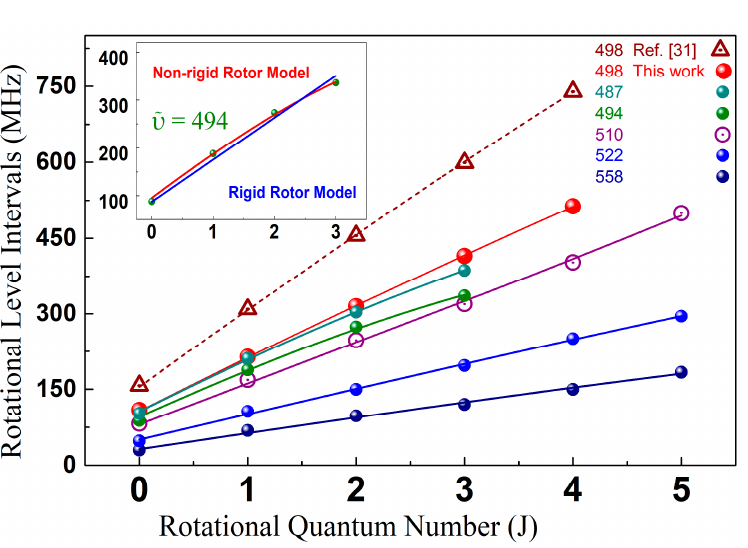
Figure 4. Relationship between J and the frequency rotational intervals ∆ ν for specific ro-vibrational levels in the Cs 2 0 + u state. Experimental data, shown in colorful symbols were fitted by the nonlinear non-rigid-rotator model. The former incorrect calibrated values for ˜ v = 498 [31], which were misprinted as ˜ v = 499 in the reference, are also presented as triangles for comparison.